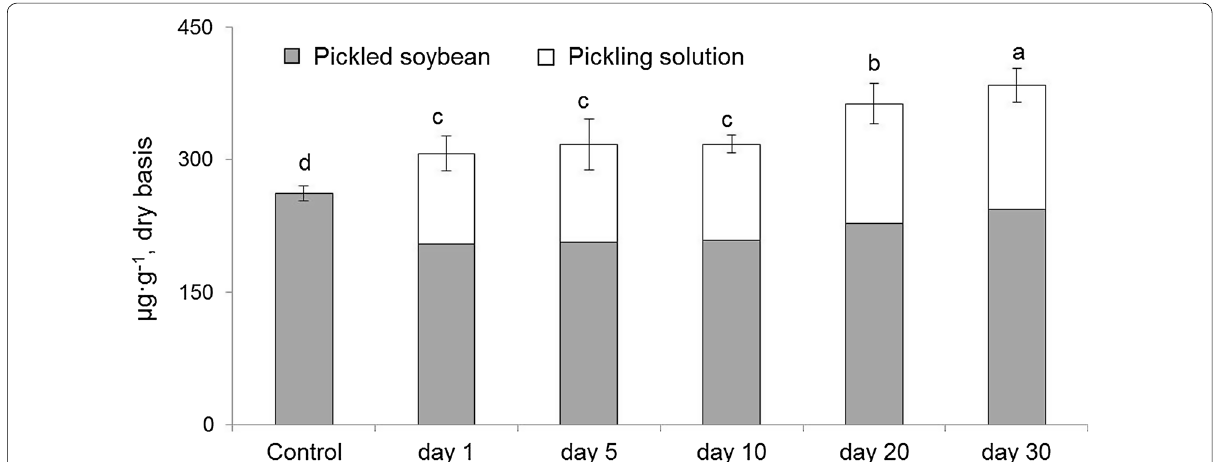
Fig. 1 Sum of total phenolics content in the pickled soybeans and pickling solution as a function of pickling period ( P < 0.05, n untreated soybeans; day 1–30: the pickling